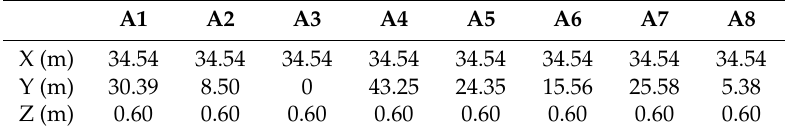
Table 11. The coordinates of gas sensor in optimal deployment scheme based on PSO algorithm. A1